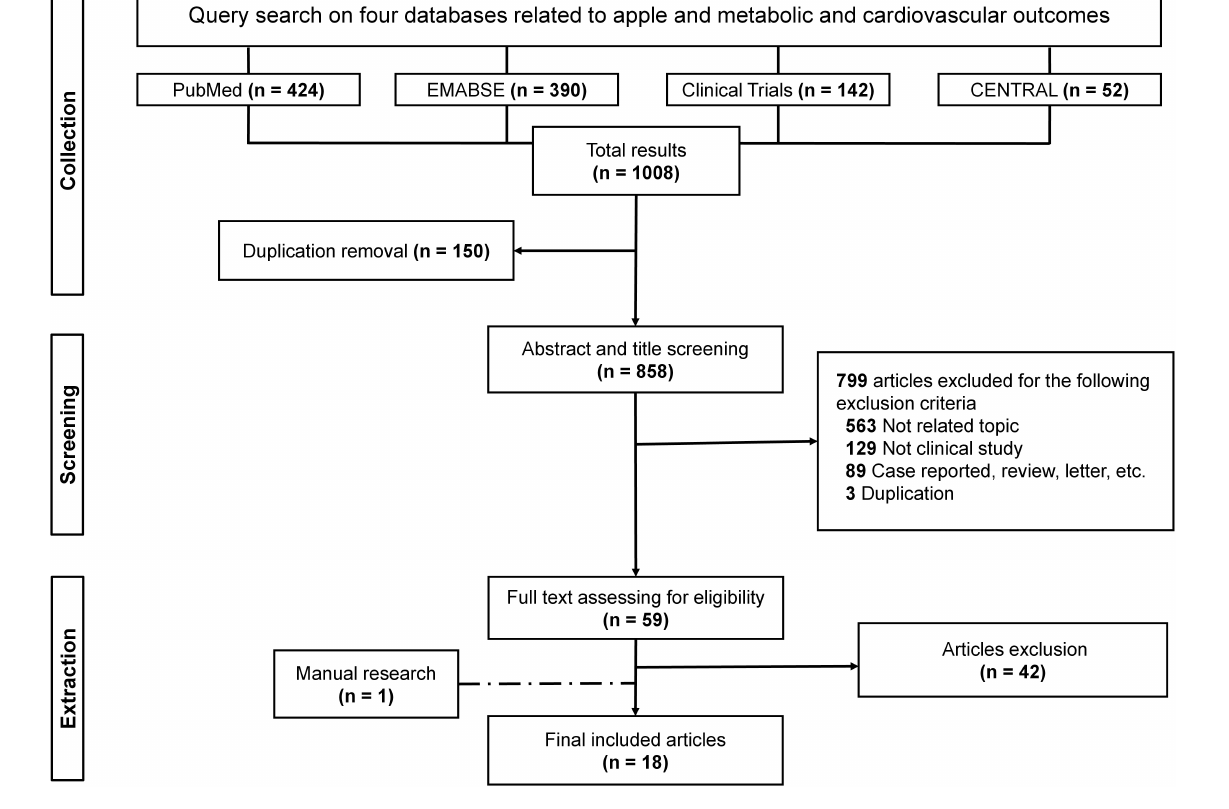
FIGURE 1 | Flowchart of the study selection